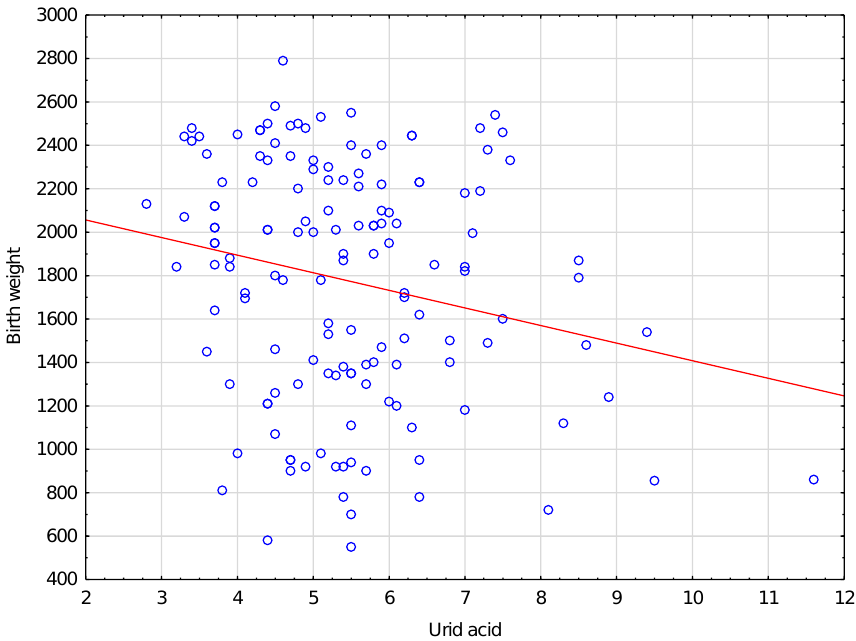
Figure 1. Scatterplot and a linear regression line between birth weight and uric acid levels in the <3rd PC group. The red line shows the regression line showing the relationship between birthweight < 3rd PC and uric acid level; blue hollow circles—patients who gave birth babies with birthweight < 3rd PC.